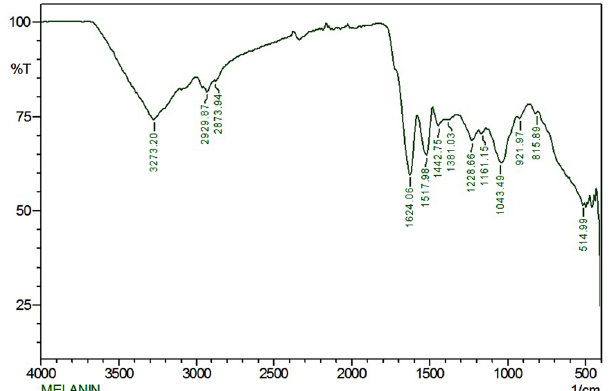
Figure 3. FTIR spectra of melanin showing a broad absorption spectra at 3273 cm − 1 which may be due to characteristic O-H stretching or N-H stretching vibrations of the carboxylic acid, and phenolic groups in melanin.